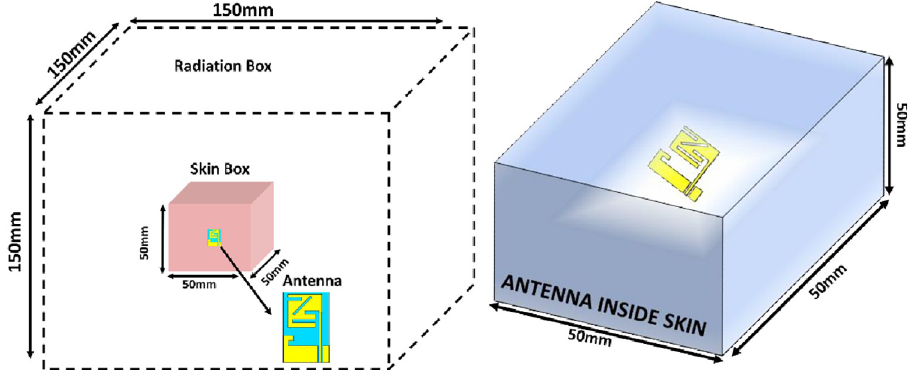
Fig 15. Perspective and side views of a human skin phantom box.